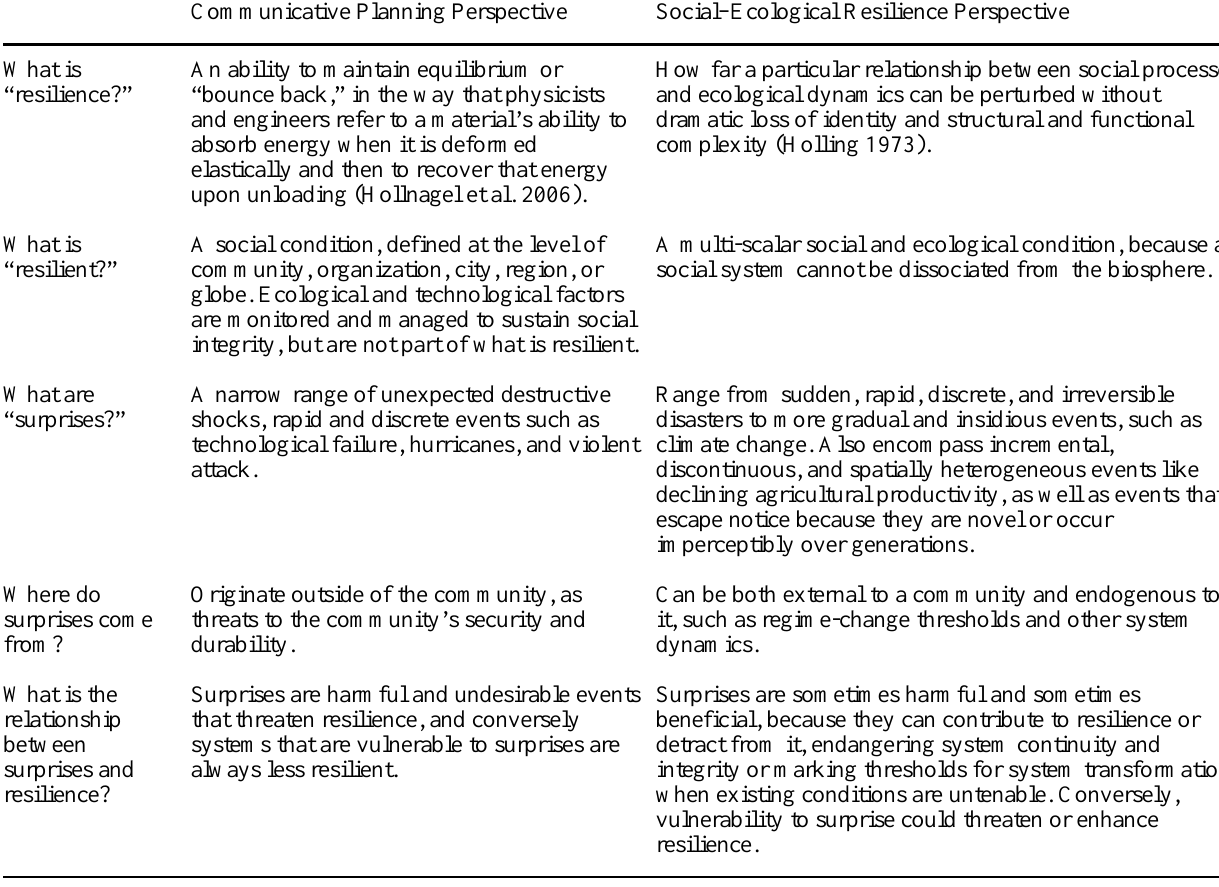
Table 1. Comparison of assumptions about resilience and